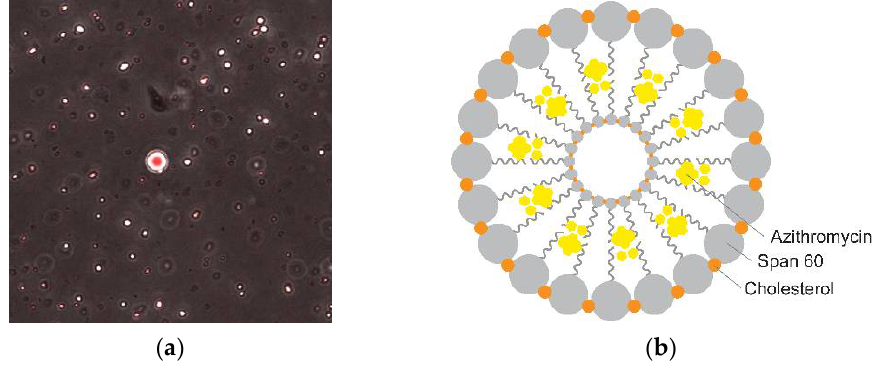
Figure 1. ( a ) Visualization of prepared AZM-loaded niosomes stained with Nile red dye that indicated lipid droplet as a red-stained vesicle under confocal laser scanning microscope; ( b ) schematic illustration of AZM-loaded niosomes prepared from cholesterol and Span ® 60 (adapted from Moghassemi and Hadjizadeh 2014 [25]).